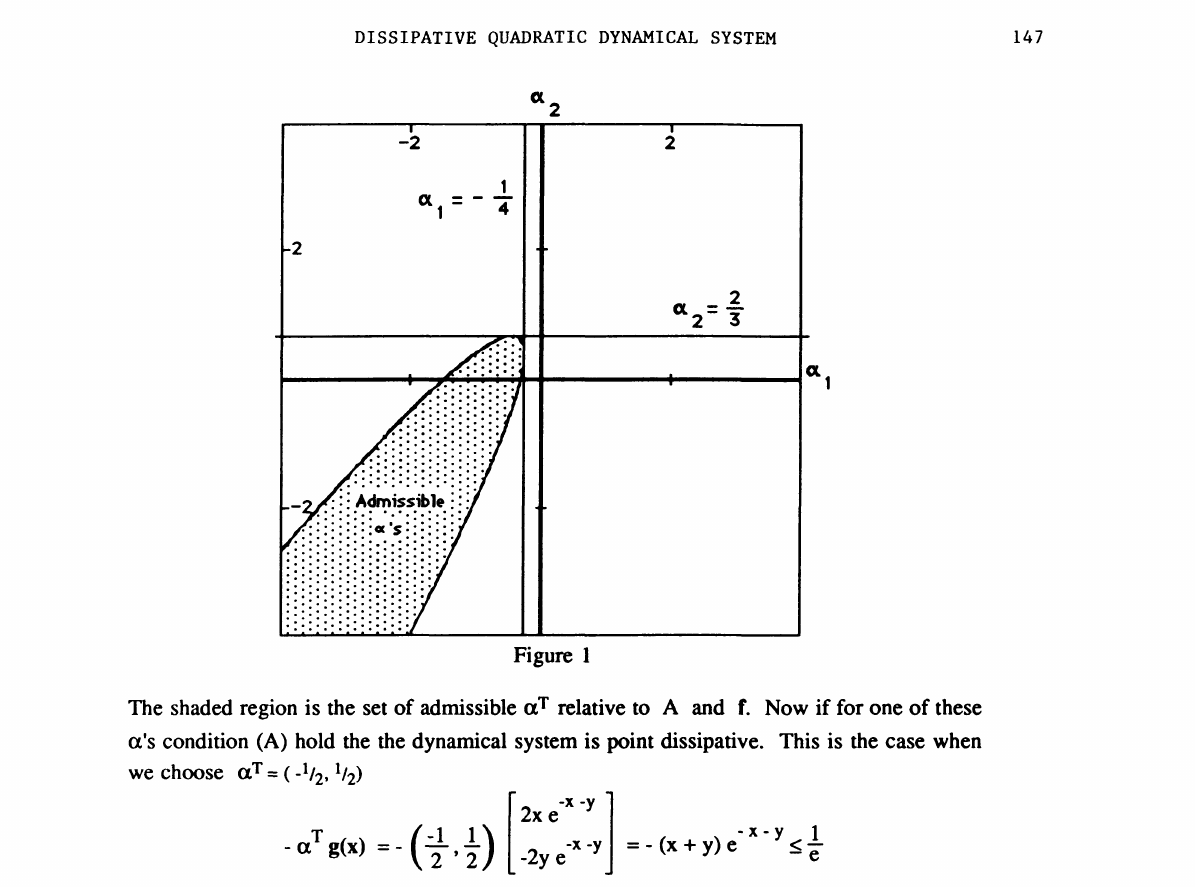
and the value of the determinate is 0.75 and the diagonal elements are and 1. Here is the graph [6 of some of the